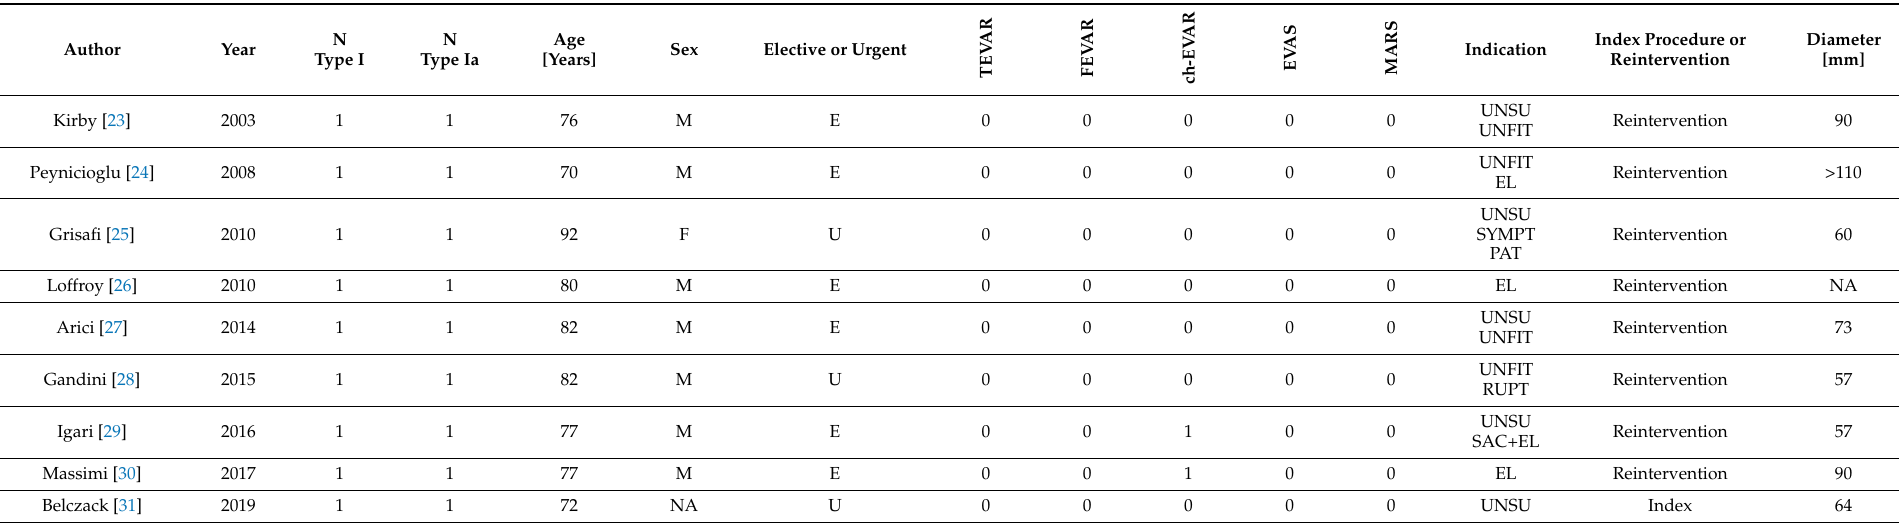
Table 2. Baseline data on included case reports: patient demographics and indication for